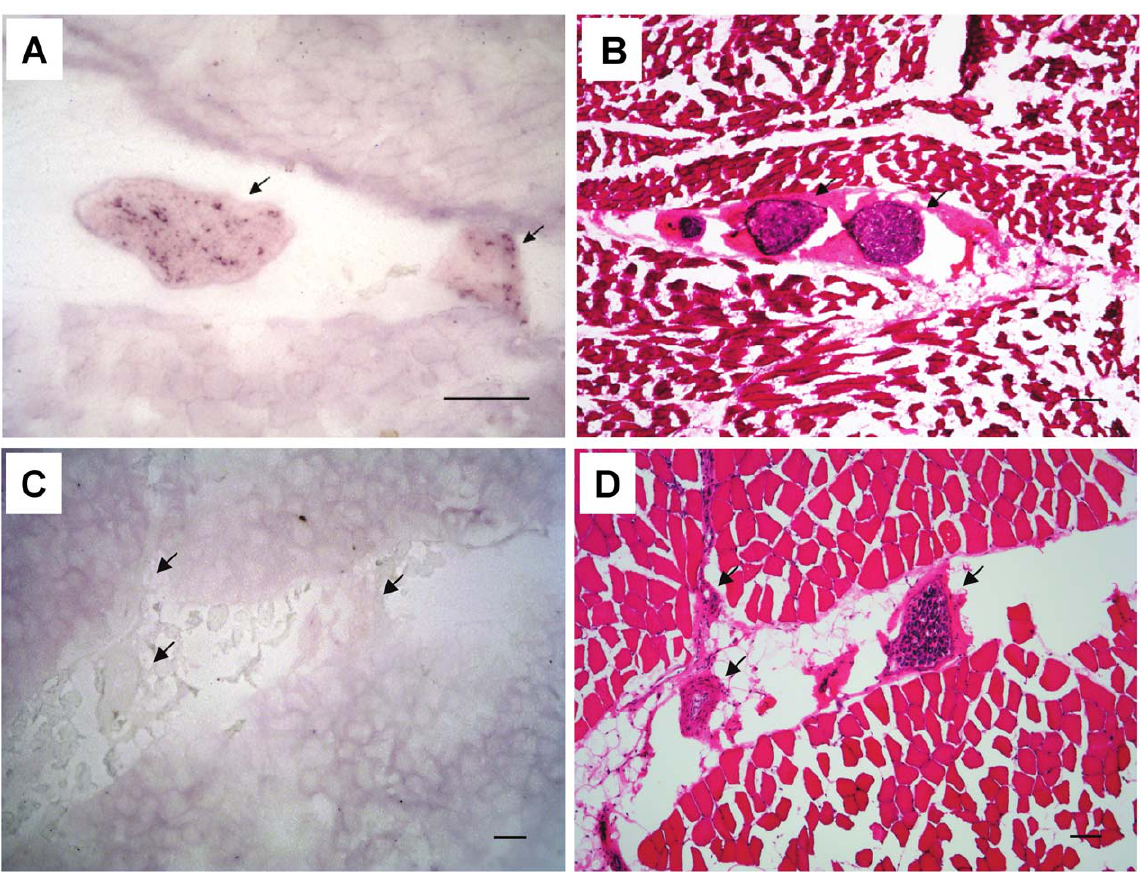
Figure 4. Intramuscular location of PrP TSE in skeletal muscle tissue of CWD-infected WTD. (A) Tissue-blot from M. glutaeobiceps of CWD- infected WTD (FR-WTD 2). Distinct granular endoneural PrP TSE accumulation in muscle-associated nerve fascicles visualised by immunolabelling with the monoclonal anti-PrP antibody P4. No PrP TSE accumulation could be detected in muscle fibres. (B) H&E stained slice from the same tissue block as in (A) showing nerves embedded in the muscle tissue. (C) Control tissue-blot of M. glutaeobiceps from uninfected WTD (Fa-WTD 10). (D) H&E stained slice from the same tissue block as in (C). Arrows indicate muscle-associated nerve fascicles in A–D. Bars=2 mm.